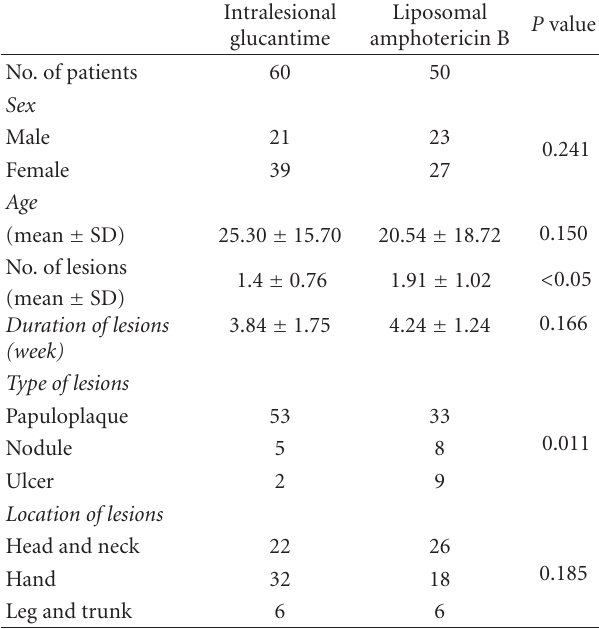
Figure 1: The flow of participants through each stage of our study. Table 1: Demographic and cutaneous leishmaniasis characteristics of the studied